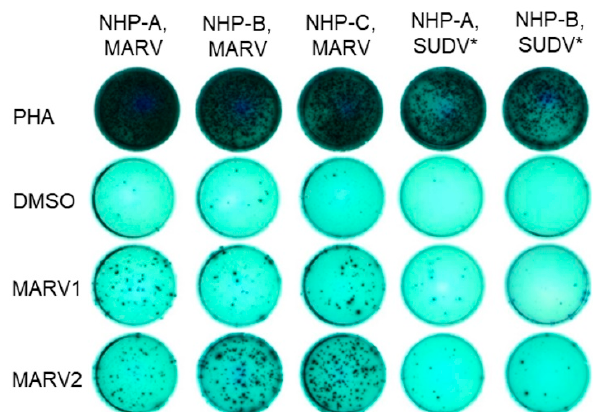
Figure 5. Post-vaccination PBMCs IFN γ ELISpot responses, plate image. Representative IFN γ ELISpot images of PBMCs from Day 56 vaccinated animals incubated with MARV peptide pools as the specific stimuli, DMSO as the negative control, and Phytohemagglutinin (PHA) as the positive control. * PBMC samples collected 14 days post-ChAd3-EBO-S (SUDV) vaccination were included as specificity controls. NHPA-C, MARV animals were vaccinated with ~1 × 10 11 PU ChAd3-MARV vaccine; NHPA-B, SUDV animals were vaccinated with ~1 × 10 11 PU ChAd3-EBO-S vaccine. MARV1: MARV peptide pool 1; MARV2: MARV peptide pool 2. Table 4. Post-vaccination PBMCs IFN γ ELISpot responses, spot counts. Days Post-ChAd3- Animal ID Animal MARV Vaccination